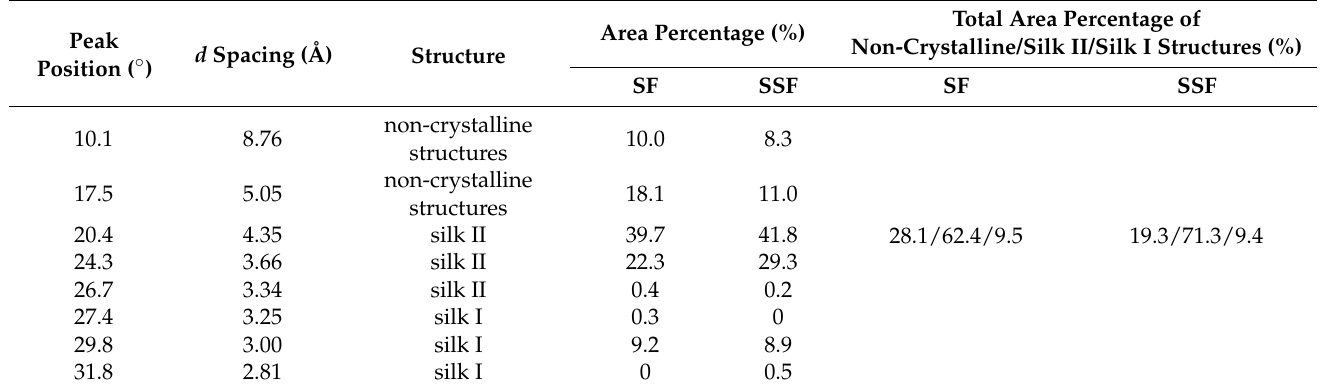
Figure 4. Curve fitting result of XRD spectra of ( a ) SF and ( b ) SSF. Table 1. Curve-fitting results of SF and SSF.